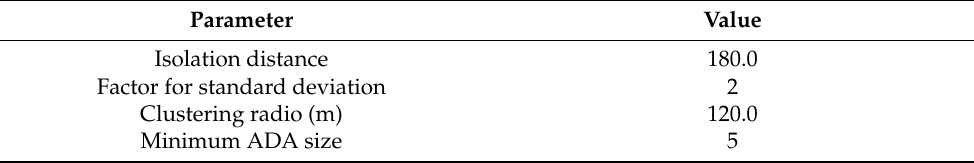
Table 2. Main processing parameters for the definition and identification of